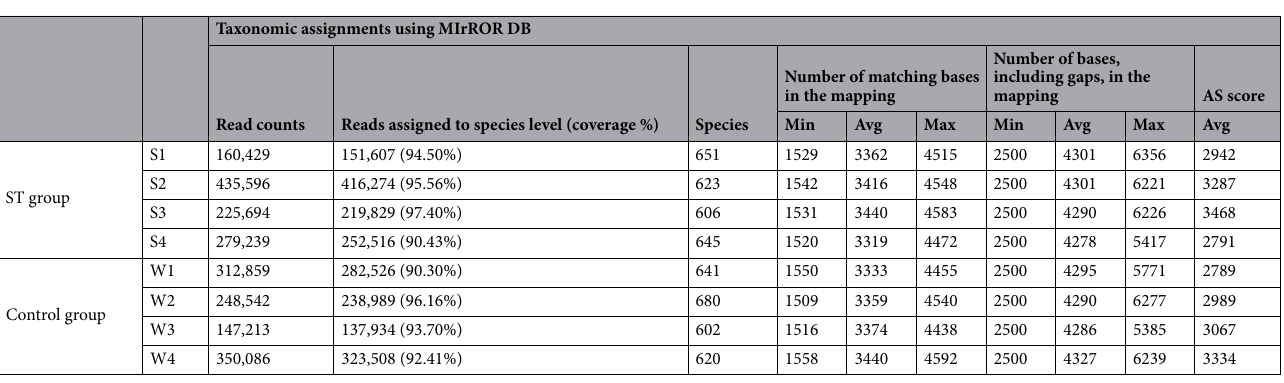
Table 3. Summary of taxonomic assignment results of reads generated using 16S–23S operon sequencing.